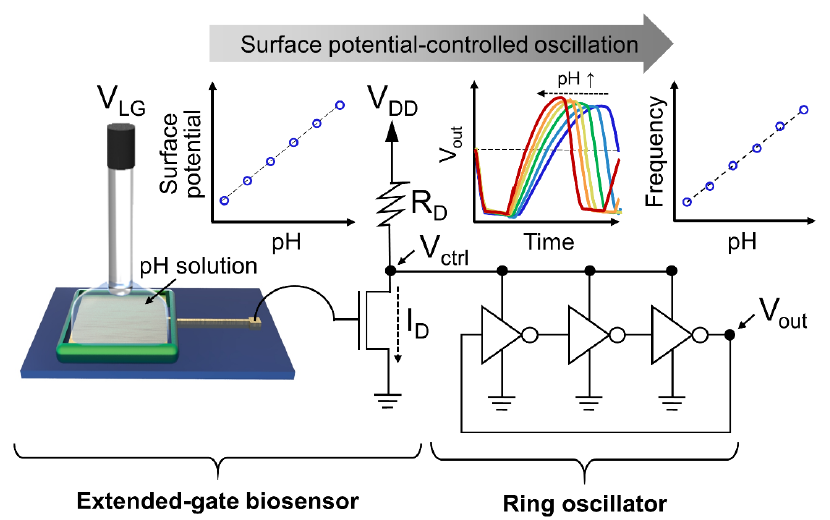
Figure 1. Schematic illustration of surface potential-controlled oscillation. An extended gate (i.e., sensing electrode) that generates surface potential based on pH is connected to a readout transistor, where surface potential is converted to drain current ( I D ). Subsequently, I D that flows through the load resistor ( R D ) determines the control voltage ( V ctrl ), which is input to the ring oscillator that generates an oscillation signal. Oscillation frequency is utilized as an output parameter for pH sensing.